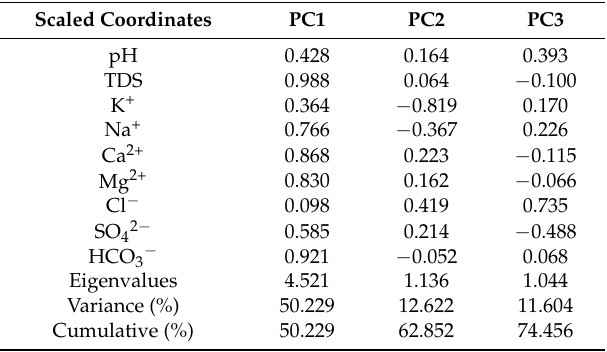
Table 2. Factor loadings and eigenvalues of the eight extracted factors.